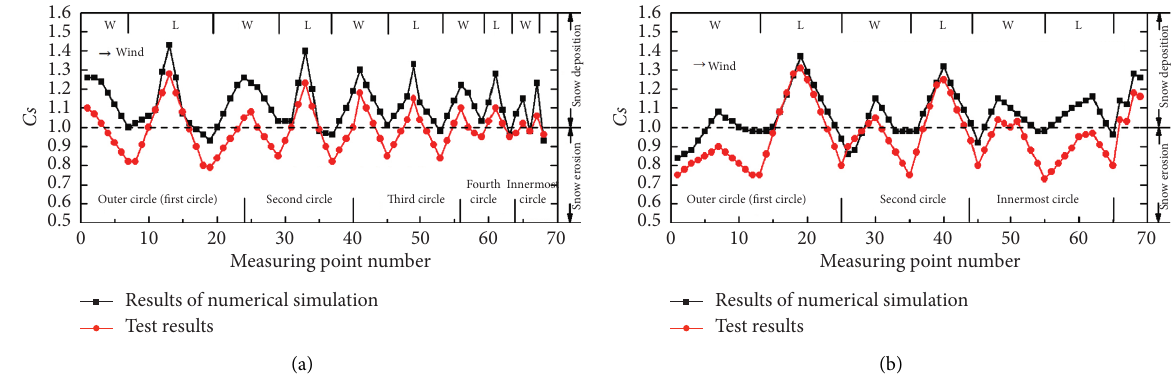
Figure 15: Comparison of the results from tests and simulations. (a) Gymnasium. (b) Stadium.